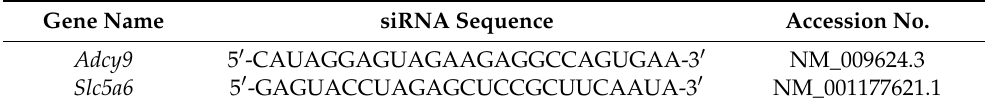
Table 1. Double-stranded siRNA sequence.